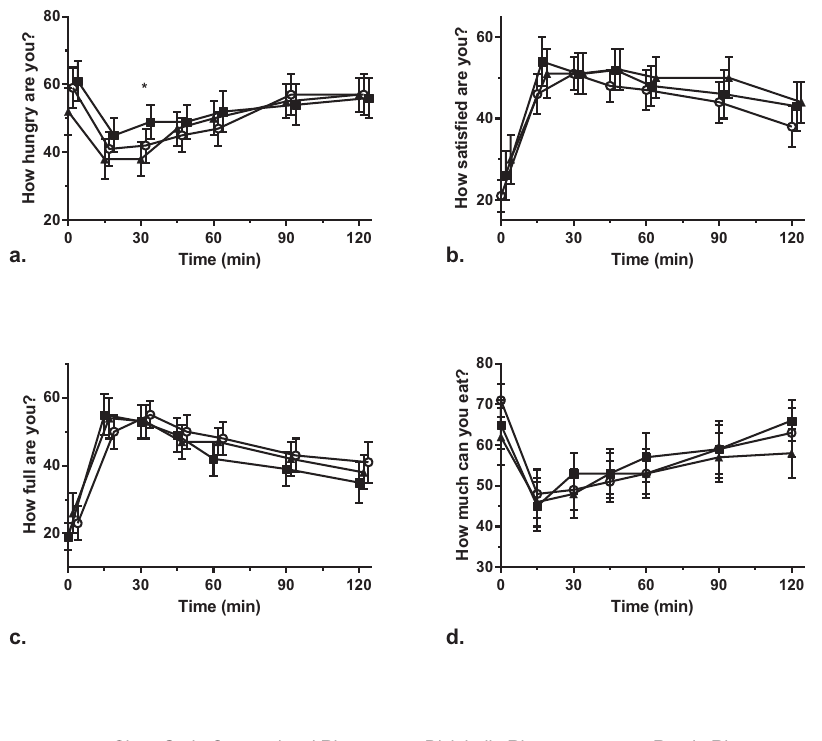
Figure 3. Appetite ratings. ( a ) Hunger “Not hungry at all” (0 mm) to “I have never been more hungry” (100 mm); ( b ) Satisfaction “I am completely empty” (0 mm) to “I cannot eat another bite” (100 mm); ( c ) Fullness “Not full at all” (0 mm) to “Totally full” (100 mm); ( d ) How much I can eat “Nothing at all” (0 mm) to “A lot” (100 mm). p -Values calculated with Proc MIXED analysis of variance with LSMean comparison between treatments. Table 5. Treatment palatability (mean ± SEM) from VAS assessment * in healthy adults ( n = 18).